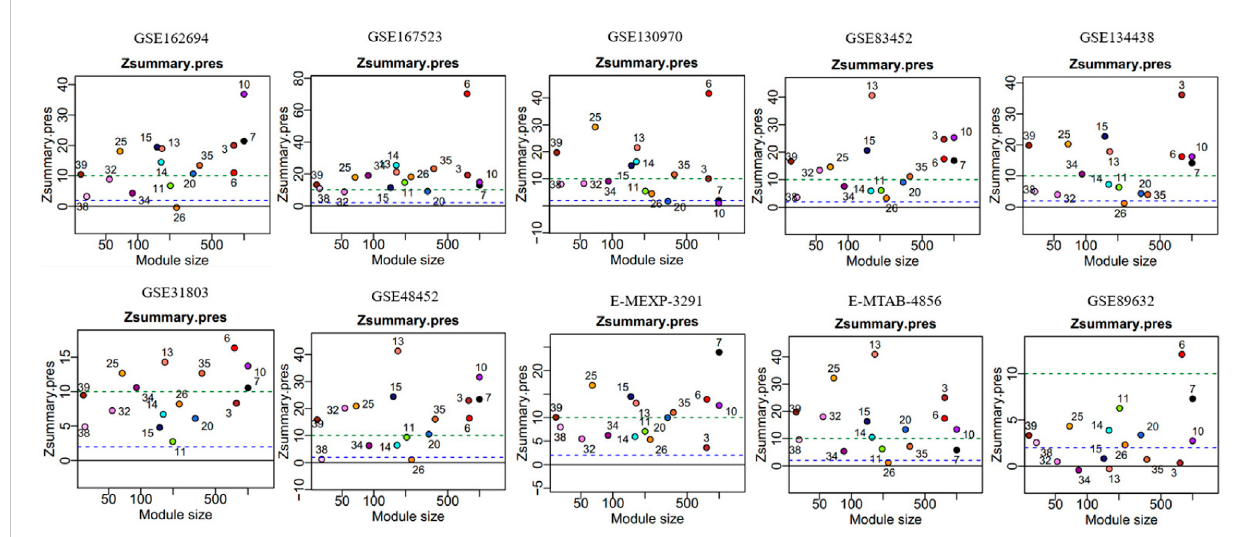
FIGURE 3 Gene network modules from GSE135251 are well preserved in the other ten datasets. The y -axis represents preservation statistics and the x -axis is the number of genes in each module. The dashed blue and green lines indicate the thresholds Z = 2 and Z = 10, respectively. Zsummary < 2 implies no evidence for module preservation, 2 < Zsummary < 10 implies weak to moderate evidence, and Zsummary > 10 implies strong evidence for module preservation.